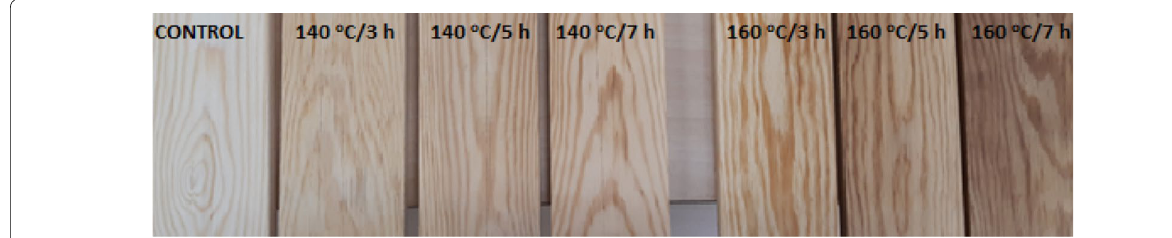
Fig. 2 Color change in Scots pine after heat treatment